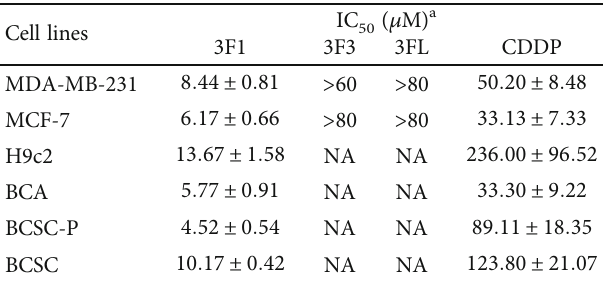
a Concentration of the respective compound required for 50% inhibition of cell viability determined by the MTT assay. The results are reported as the mean ± SD of three independent